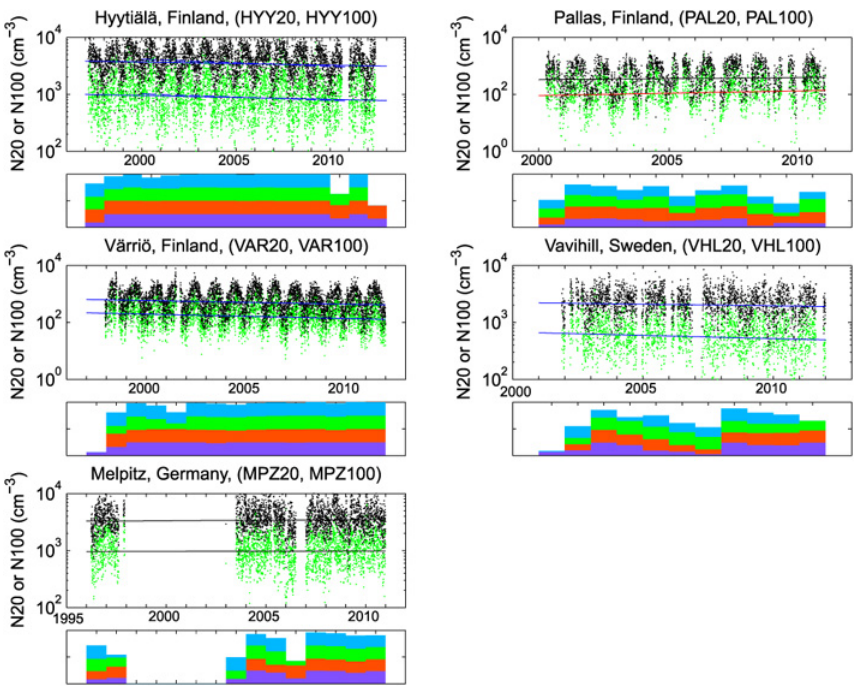
Fig. 4. Trends of size size-specified aerosol concentrations N20 (black dots) and N100 (green dots). The notation is the same as in Fig. 2, except for the dot